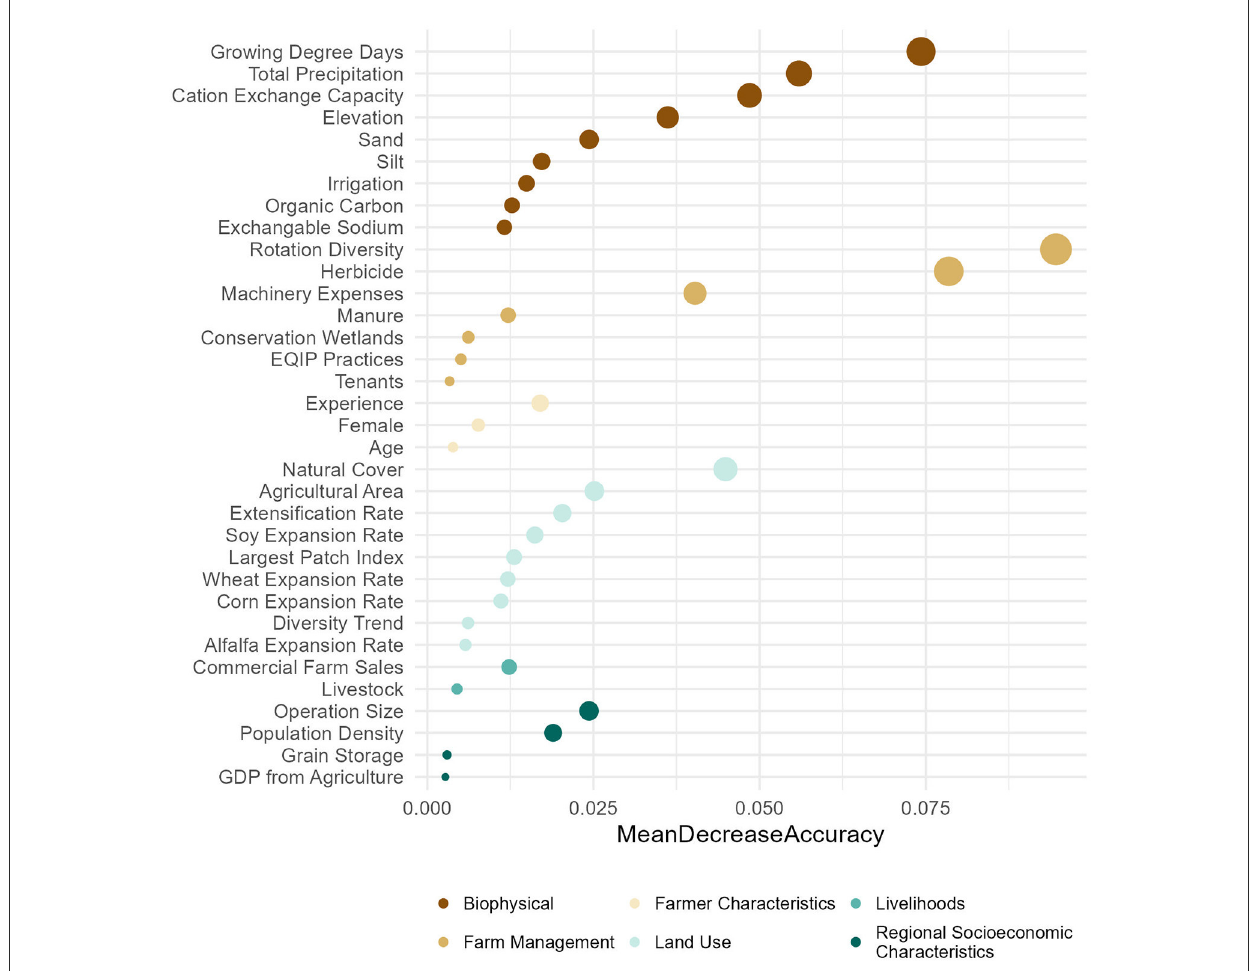
FIGURE4 Variable importance for random forests on a 70% random sample of the subset of archetypal counties ( n =